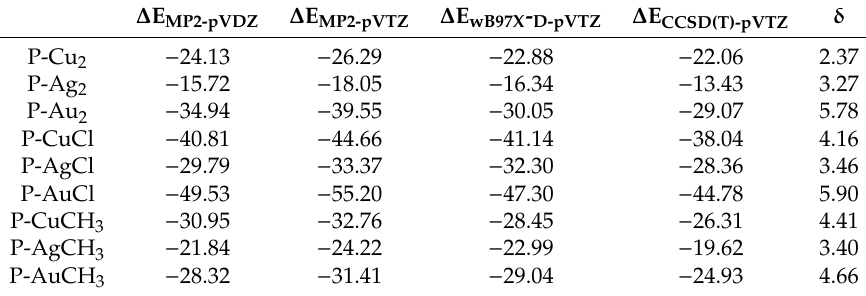
Table 1. Interaction energies corrected for basis set superposition error (BSSE) ( ∆ E, kcal / mol) with di ff erent methods in the binary systems and average deviation ( δ ) from the coupled-cluster singles and doubles augmented by a perturbative treatment of triple excitations (CCSD(T)) values. ∆ E ∆ E ∆ E ∆ E MP2-pVDZ MP2-pVTZ wB97X - D-pVTZ CCSD(T)-pVTZ